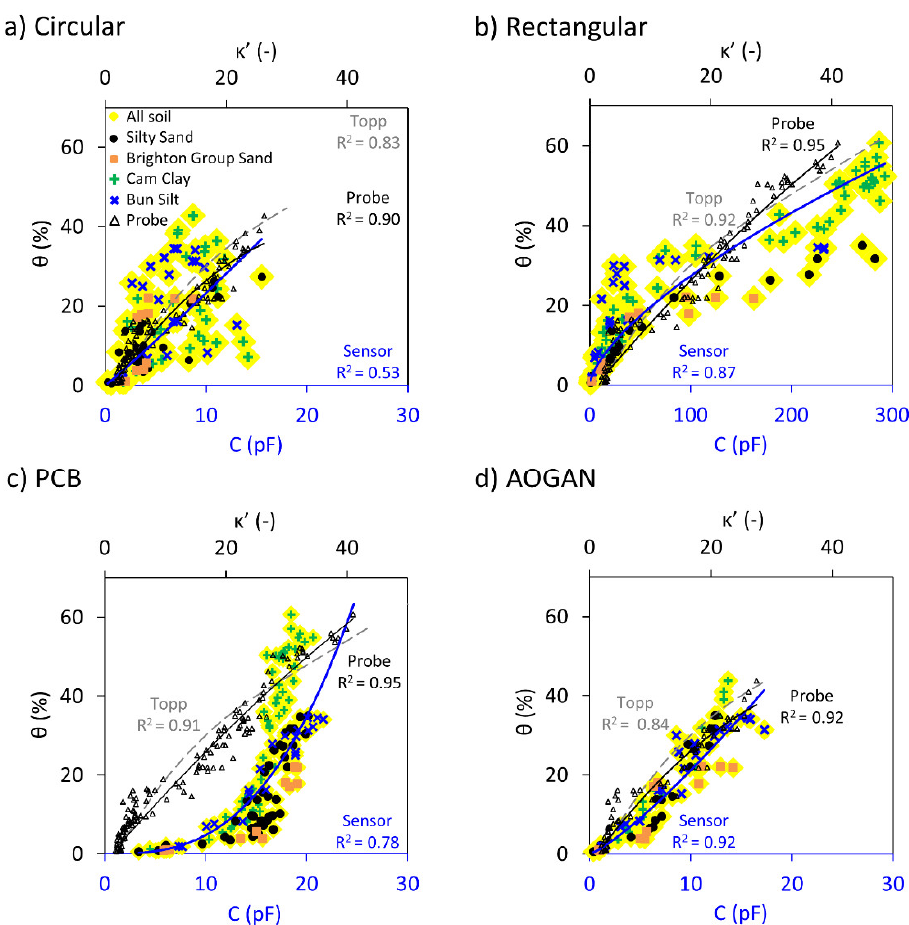
Figure 8. Combined capacitance, C and dielectric constant, κ ’, data versus volumetric water content, θ , for: ( a ) Circular, ( b ) Rectangular, ( c ) PCB and ( d ) AOGAN sensors. Highlighted yellow markers capture the capacitive data for all soils and different markers represent different soil samples captured by the blue trendline. Black triangular markers and dashed trendlines correspond to dielectric measurements. Topp calibration is shown by the dashed grey trendlines.